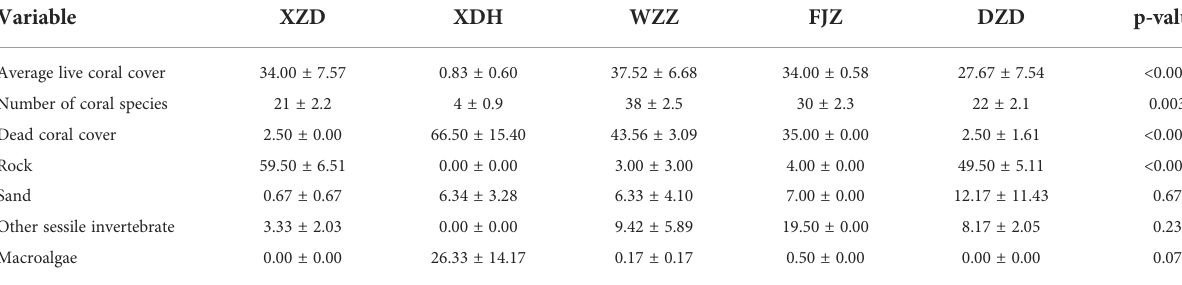
TABLE 3 Benthic reef substrate variables at each station. mean ± SE.